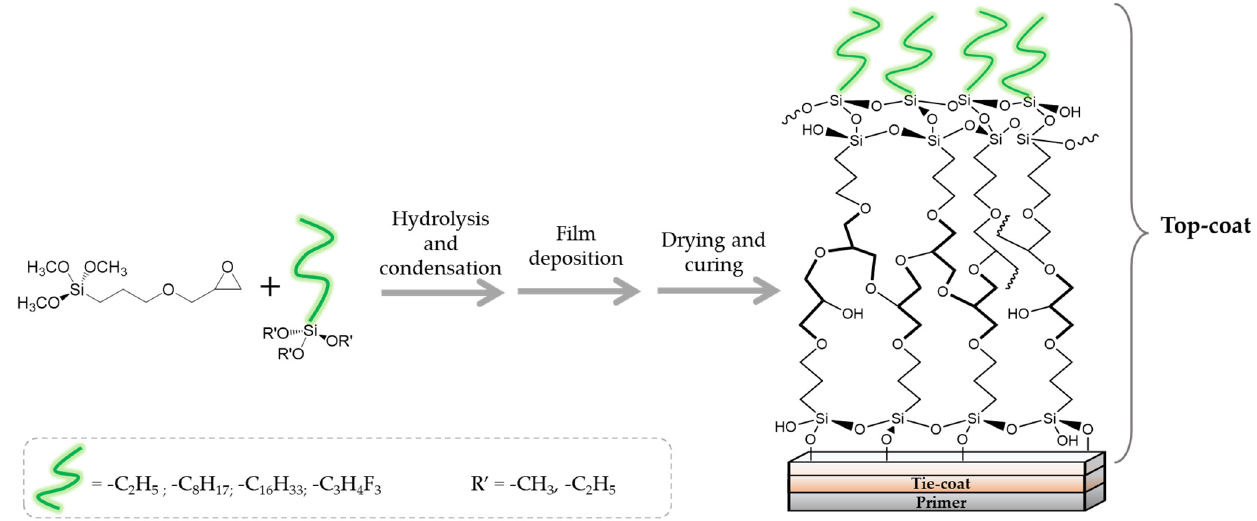
Figure 3. Sol-gel synthesis steps for hydrophobic coating preparation.